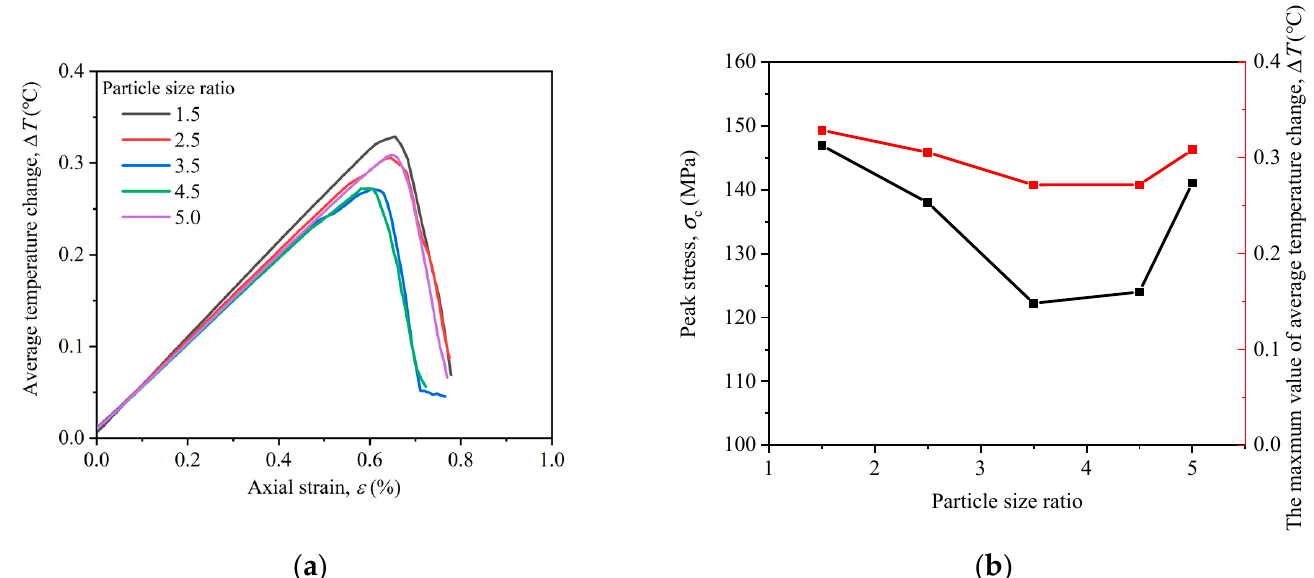
Figure 13. Effects of different particle size ratios on average temperature change ( a ), peak stress and the maximum value of average temperature change ( b ).